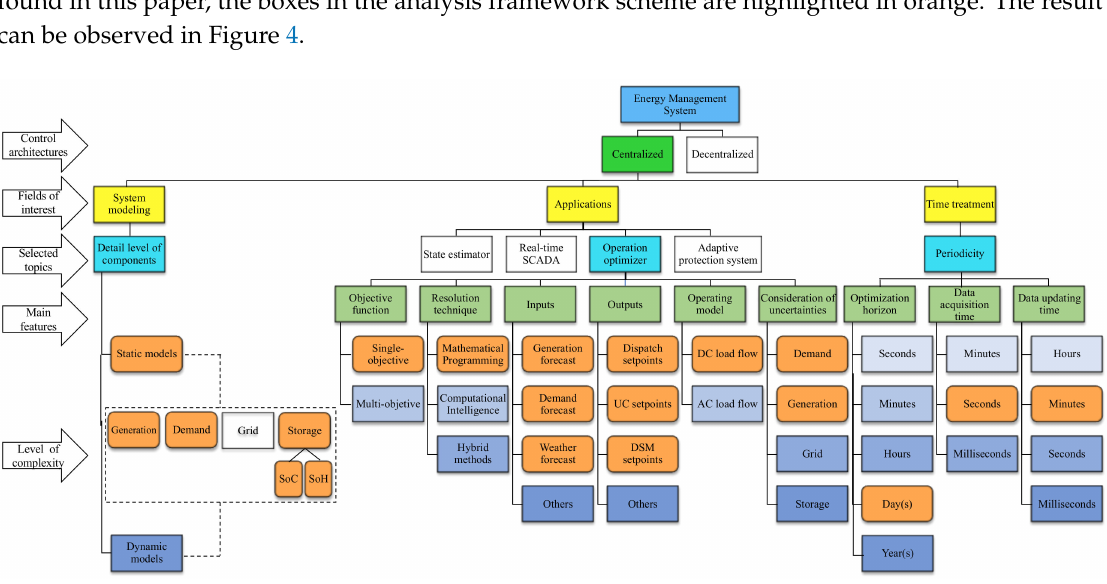
Figure 4. Example of the proposed analysis framework scheme